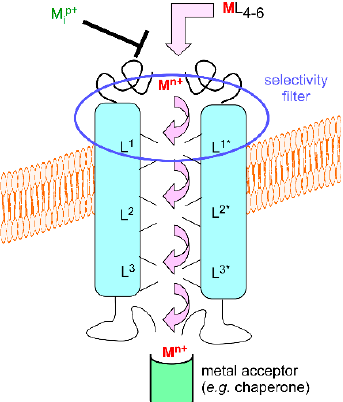
Figure 1. Schematic representation of a transmembrane metal transporter. M n + (red) is the transported cation, L 1 , L 2 , etc. the transporter-associated transient metal ligand sets, and M ip + (green) a potential metal inhibitor of